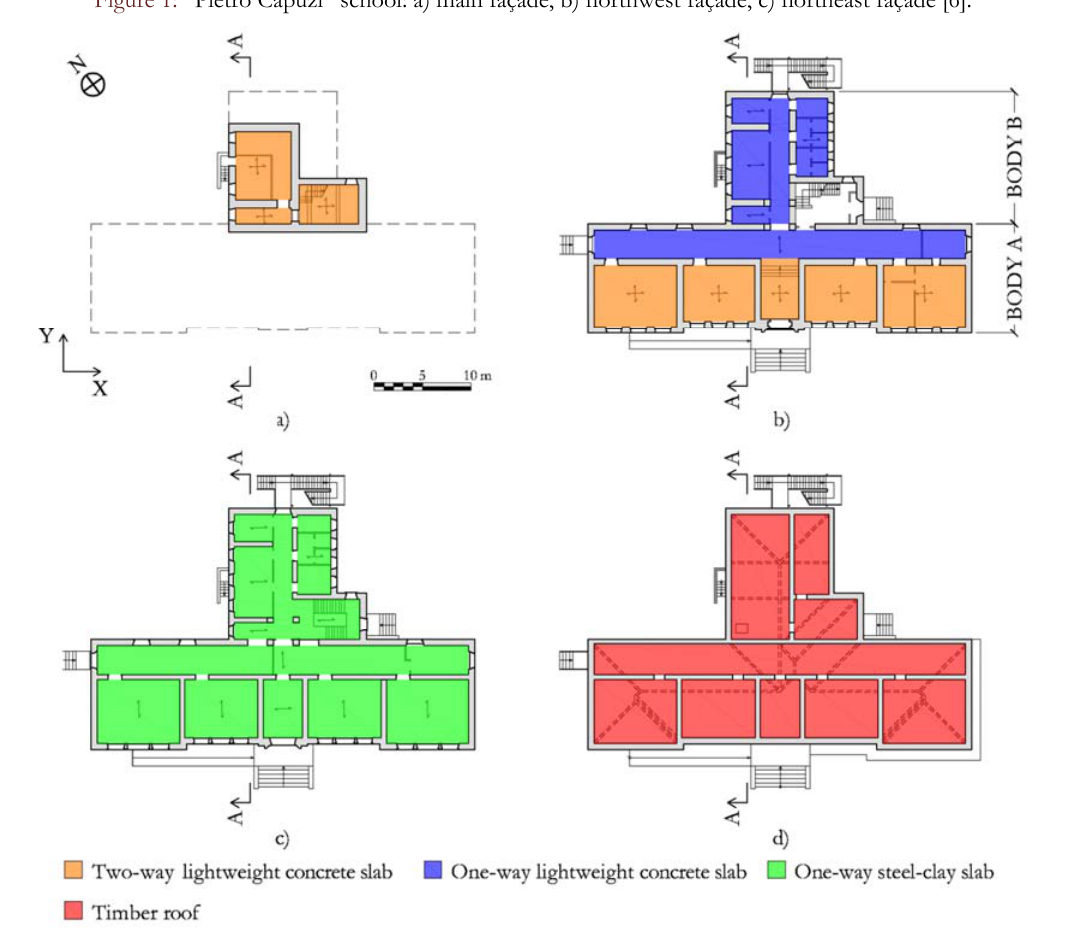
Figure 2: Plans of “Pietro Capuzi” school: a) basement, b) raised ground floor, c) first floor, d)